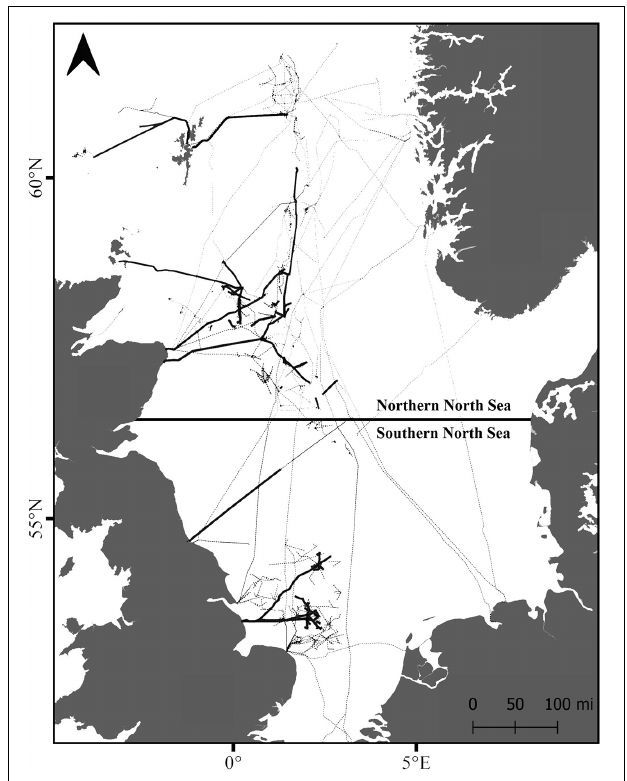
FIGURE 1 | Map of North Sea study area with line showing divide between the northern North Sea and southern North Sea. Dotted lines represent pipelines, solid black lines indicate pipelines sampled in this